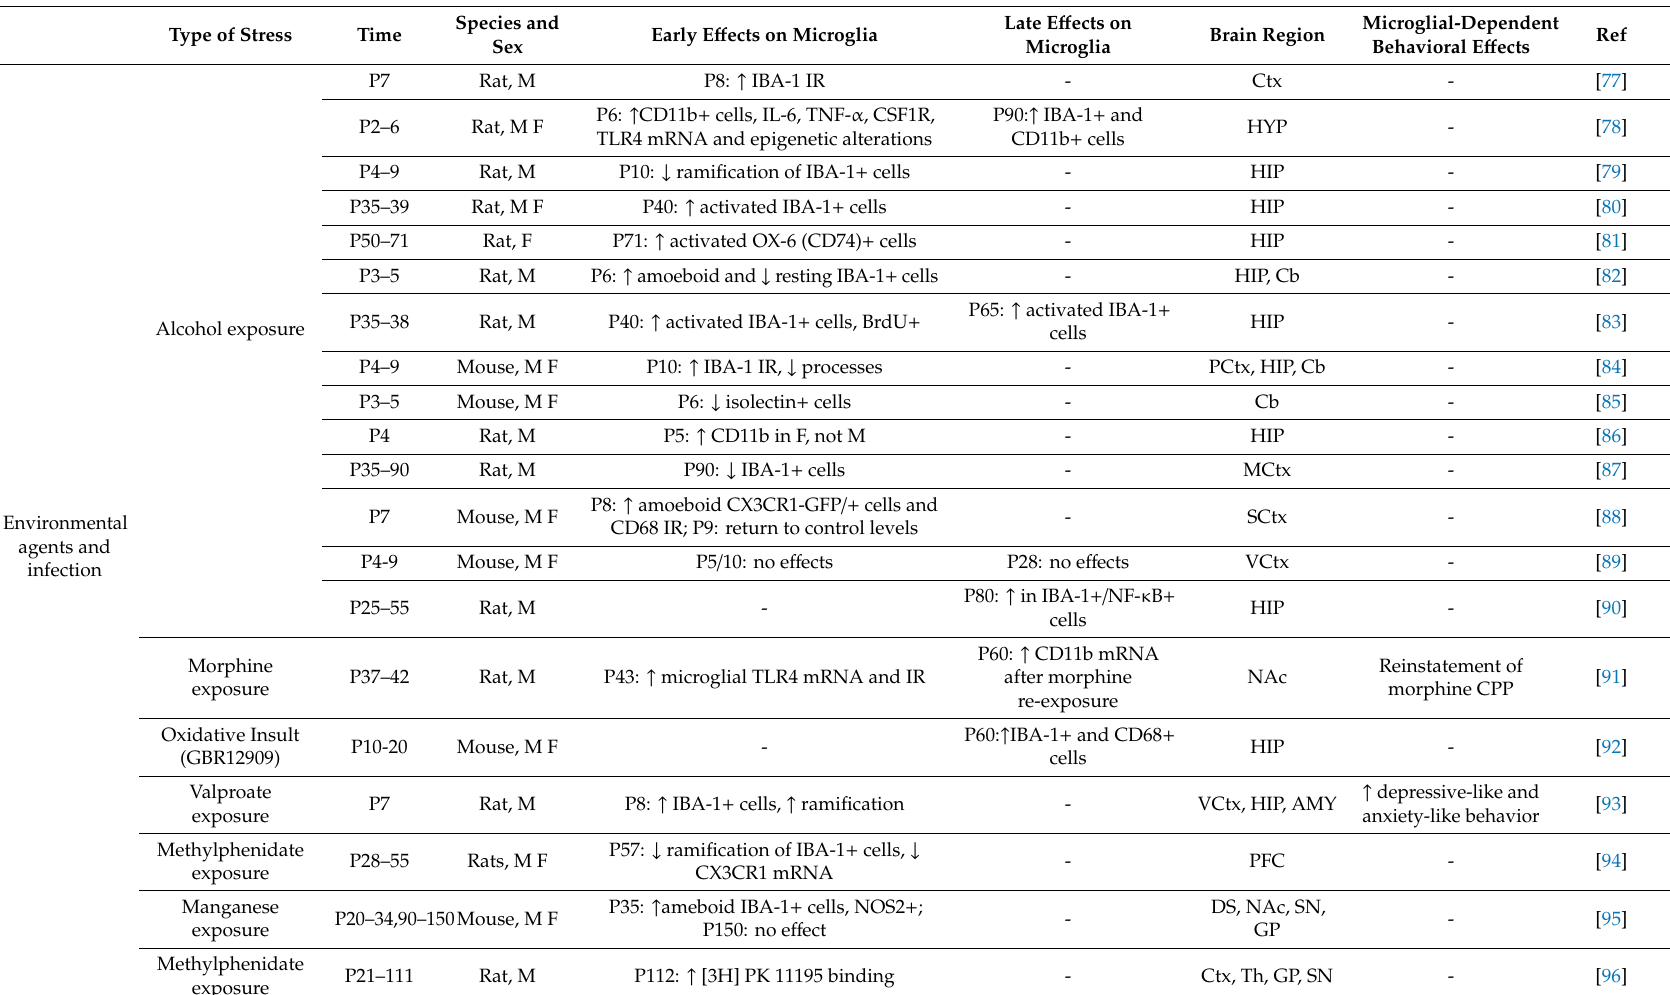
Table 3. E ff ects of postnatal environmental agents and infection on microglial cell density and phenotype and subsequent behavioral alterations. Type of